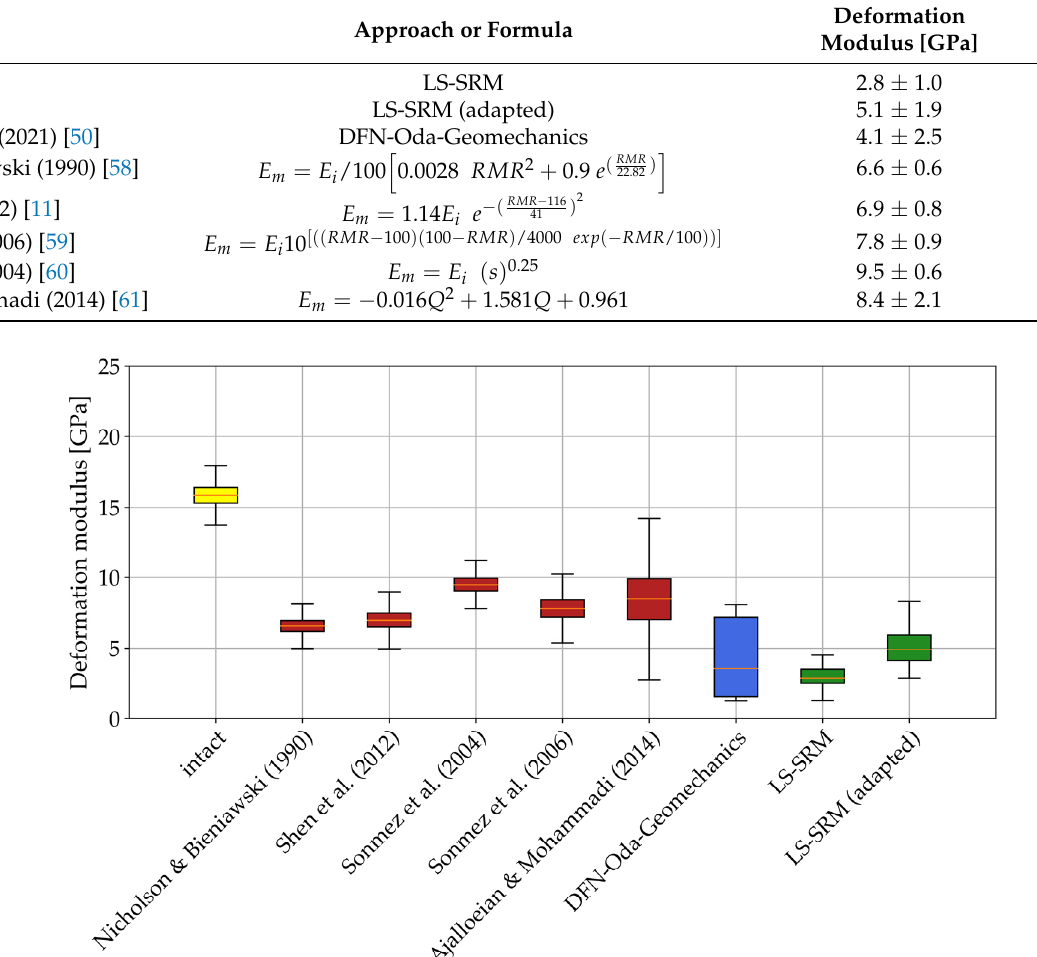
Figure 10. Comparison of calculated deformation moduli using the different upscaling